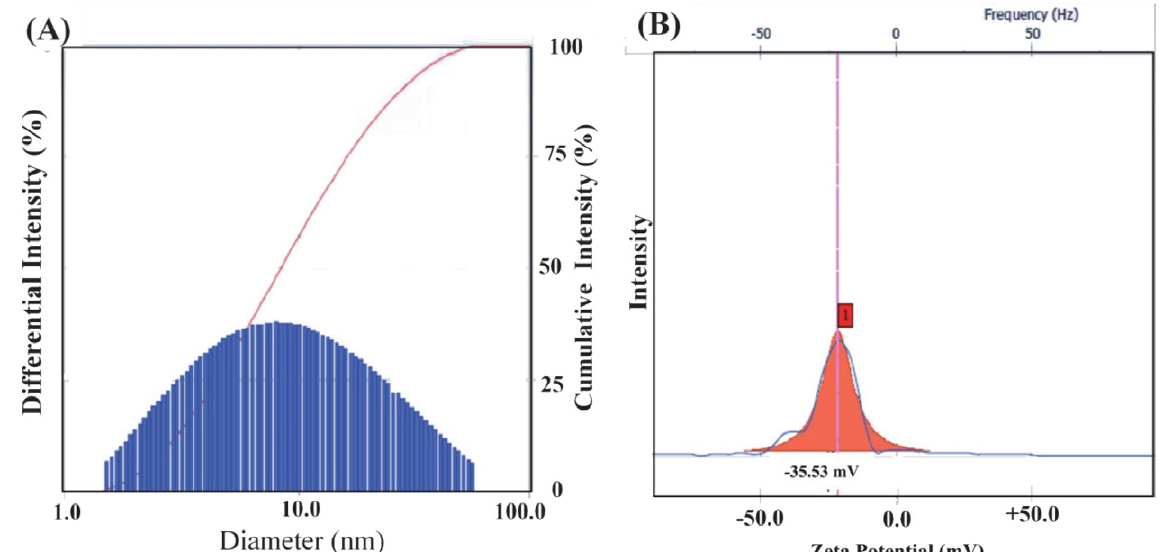
Figure 3: Particle size analysis (A) and zeta potential (B) of green synthesized